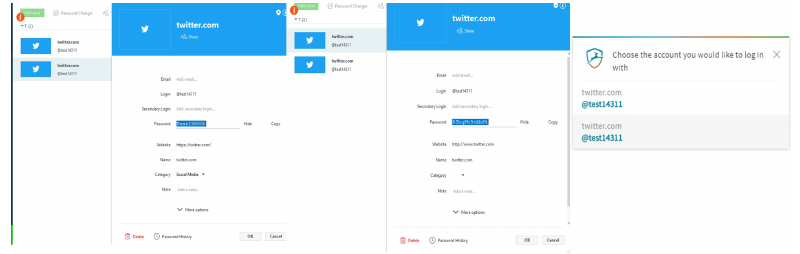
Figure A7. Dashlane does not prevent users from storing different passwords for the same account.